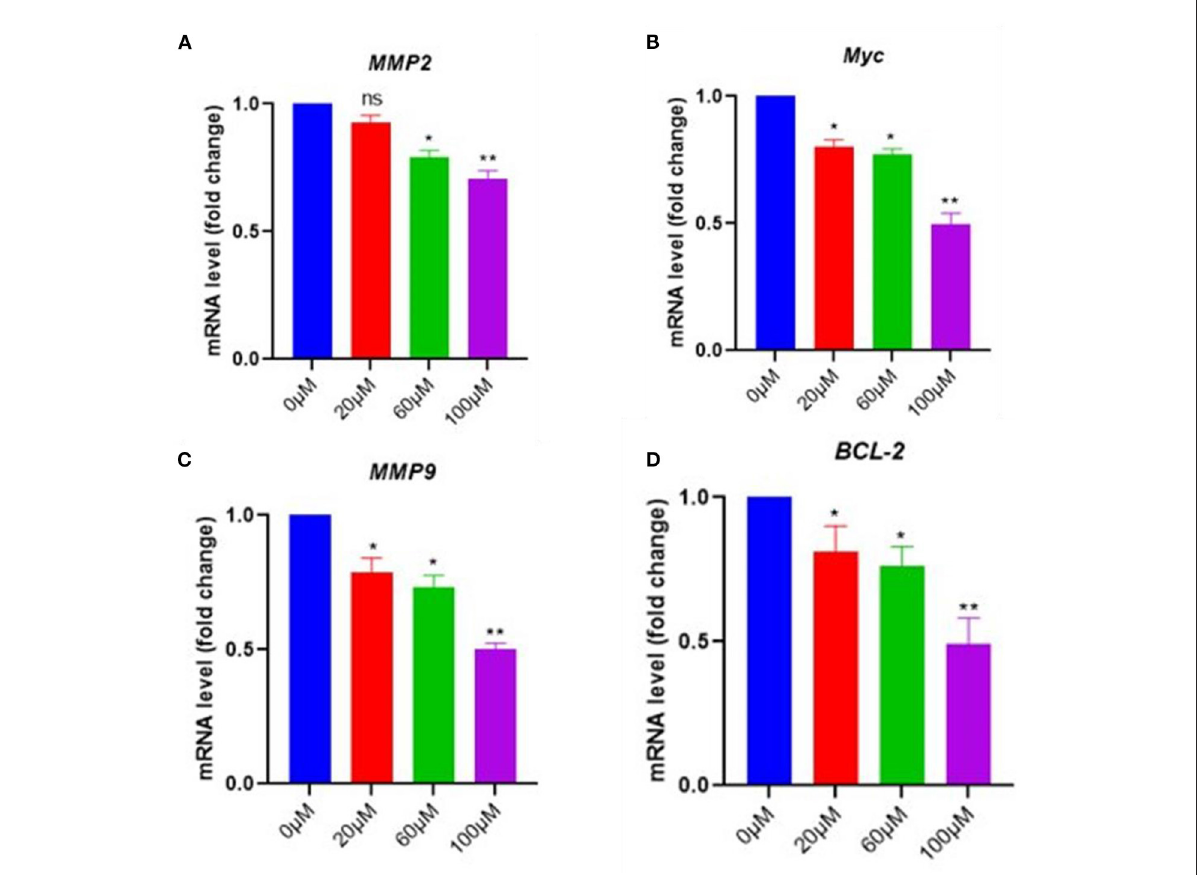
FIGURE7 In pancreatic cancer cells, EGCG reduces the RNA expression of NF- κ B downstream signaling genes. Real-time PCR (qPCR) results revealed that EGCG administration reduces the expression of NF- κ B target genes (e.g., MMP9, cMyc, MMP2, and BCL-2) in pancreatic cancer cells treated with various doses (0–100 µ M) for 48 hrs and cells were harvested, and RT-PCR was done for NF- κ B target genes (A–D) ( n = 3; * p ≤ 0.05, ** p ≤ 0.01). Statistical analysis was done using the ANOVA test for group